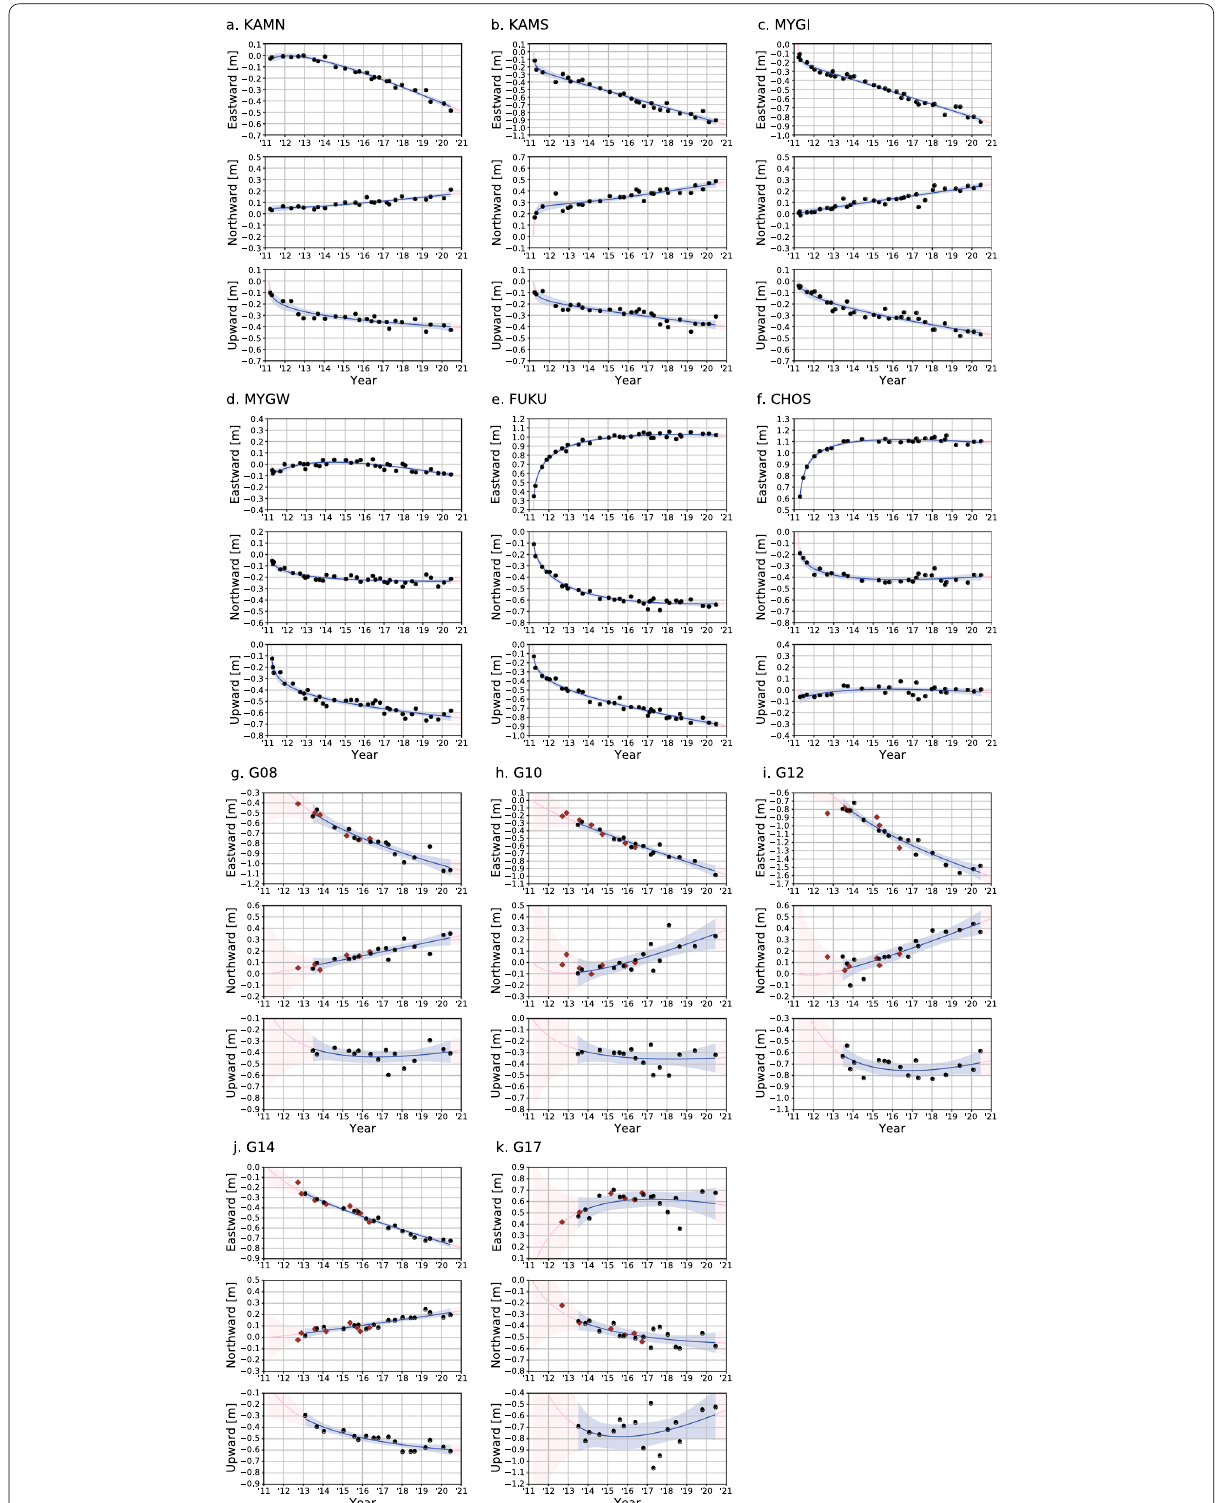
Fig. 2 Time series of postseismic seafloor displacement. Displacements with respect to the Okhotsk plate of NNR‑MORVEL56 model (Argus et al. 2011) are shown (black circles). Fitted logarithmic curves are shown as the solid lines. The 95% confidence intervals for curve fittings are shown as shaded areas. Results provided by Honsho et al. (2019) for g – k are indicated as brown